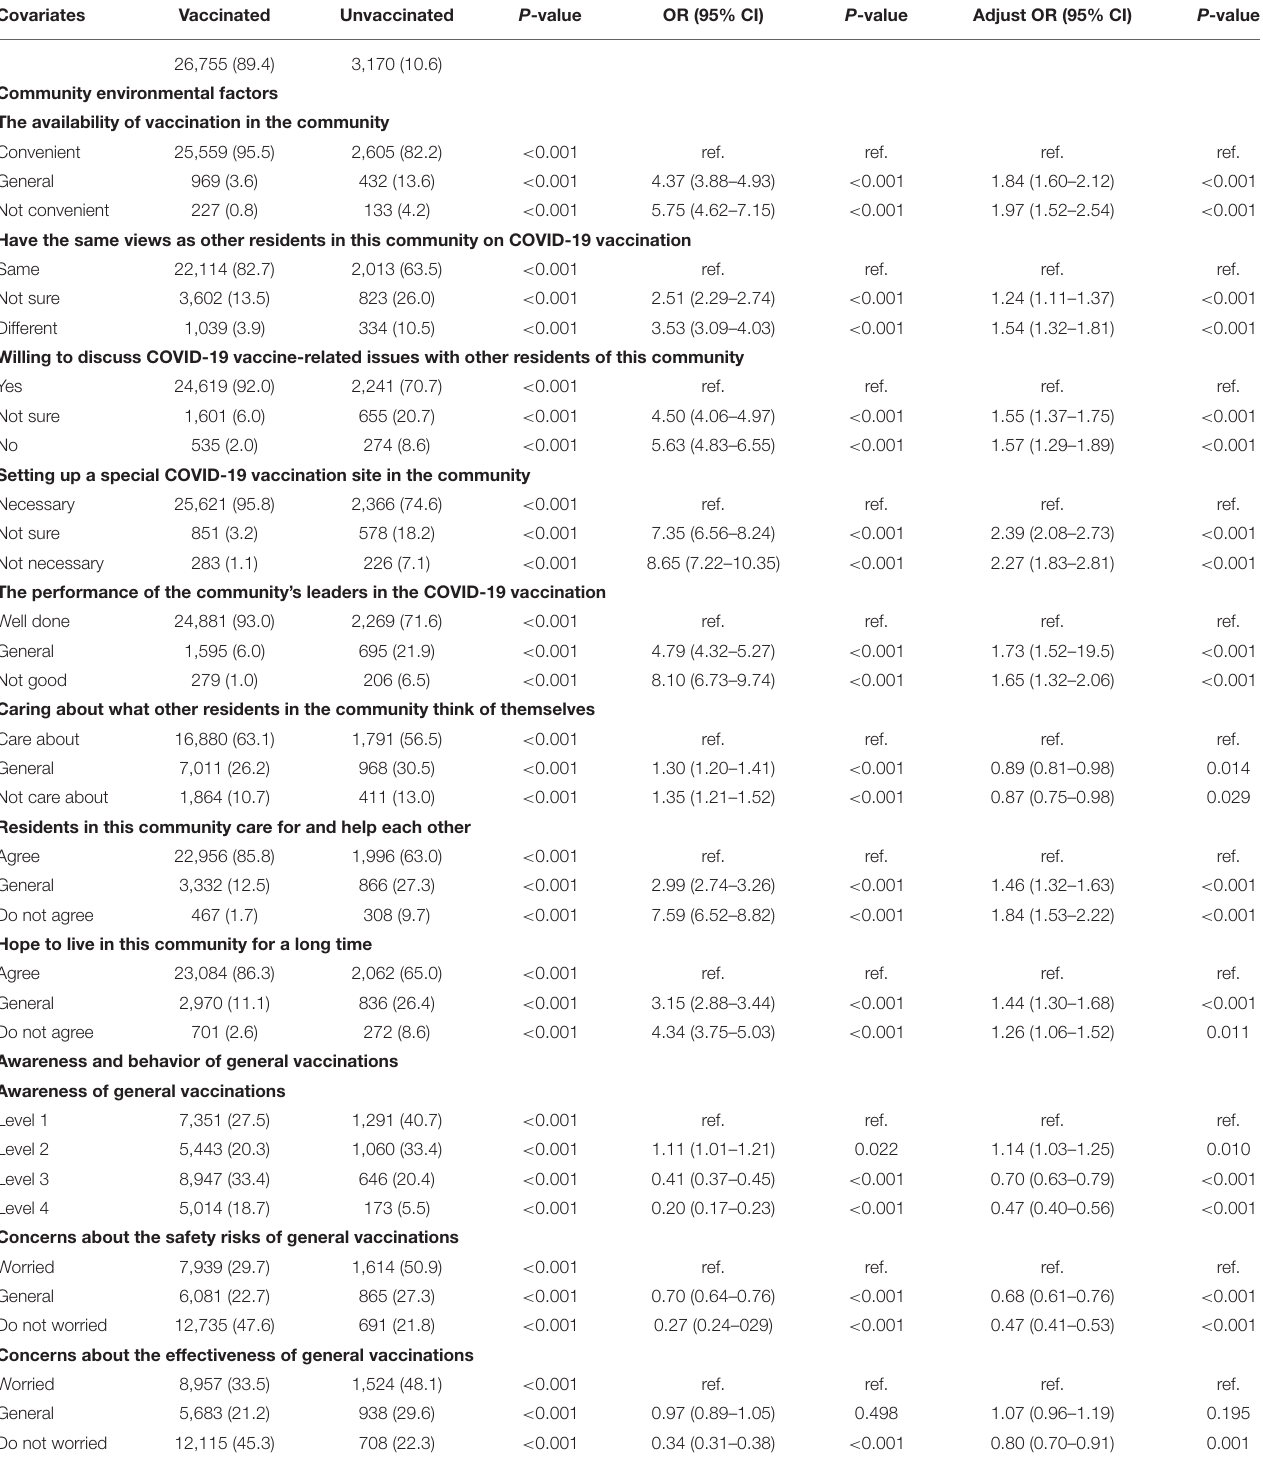
TABLE 3 | Association between background information and COVID-19 vaccination rate ( n = 29,925). Covariates Vaccinated Unvaccinated P -value OR (95% CI) P -value Adjust OR (95%